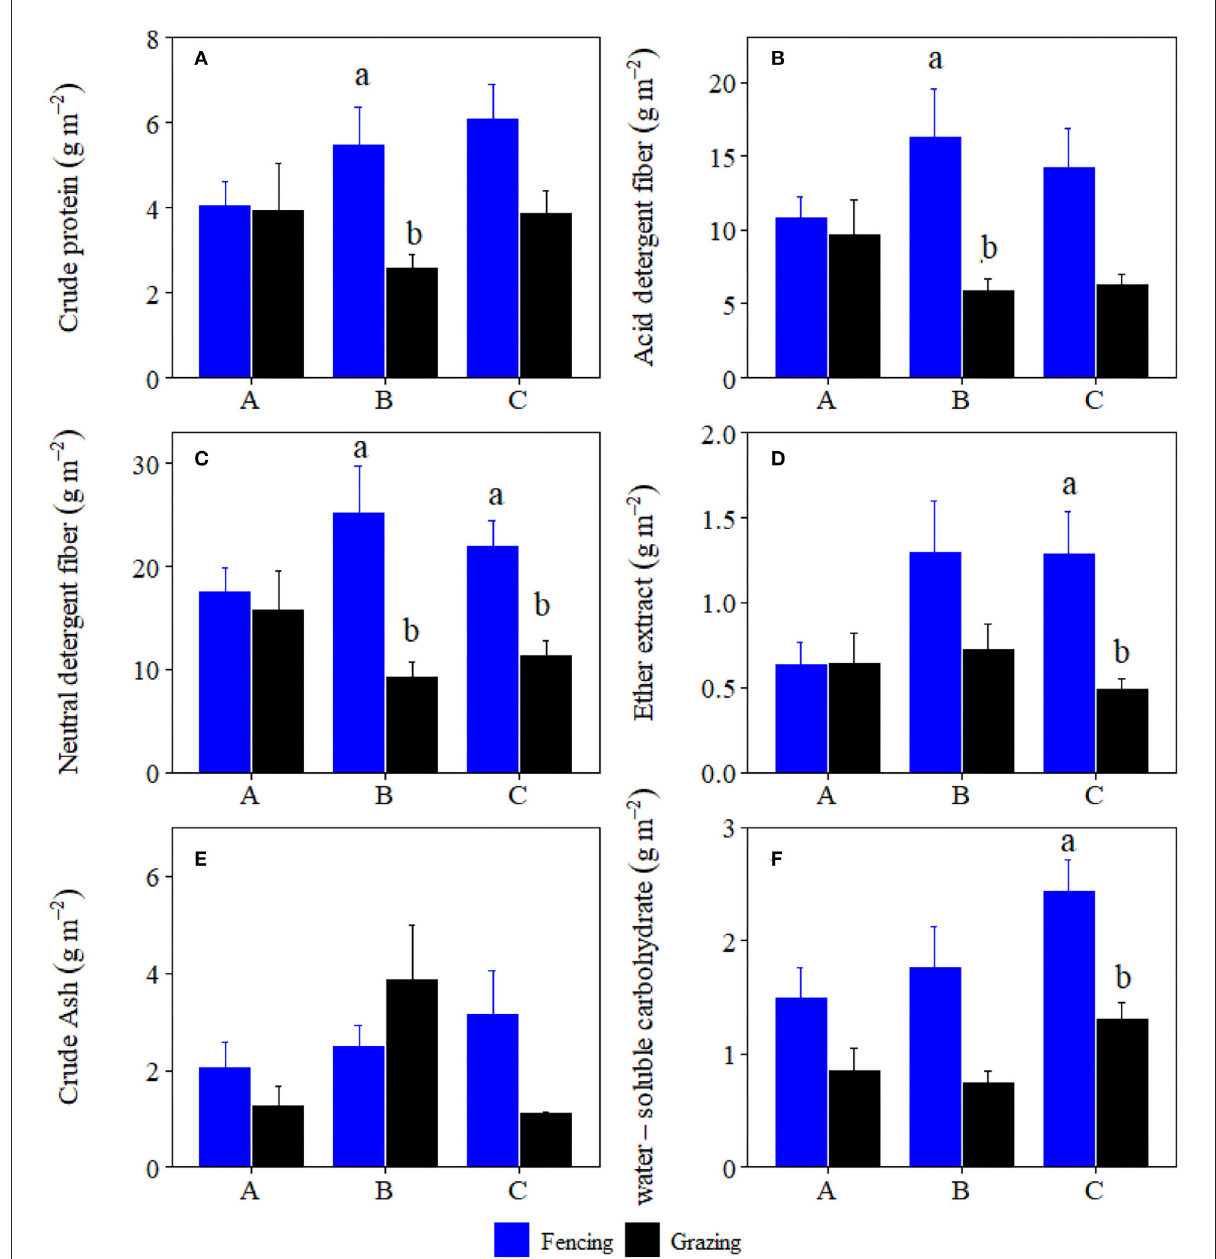
FIGURE3 Comparisons of high-quality forage (A) crude protein, (B) acid detergent fiber, (C) neutral detergent fiber, (D) ether extract, (E) crude ash, and (F) water-soluble carbohydrate storages (mean ± SE) between the fencing and grazing conditions in three alpine grasslands located at site A–C,